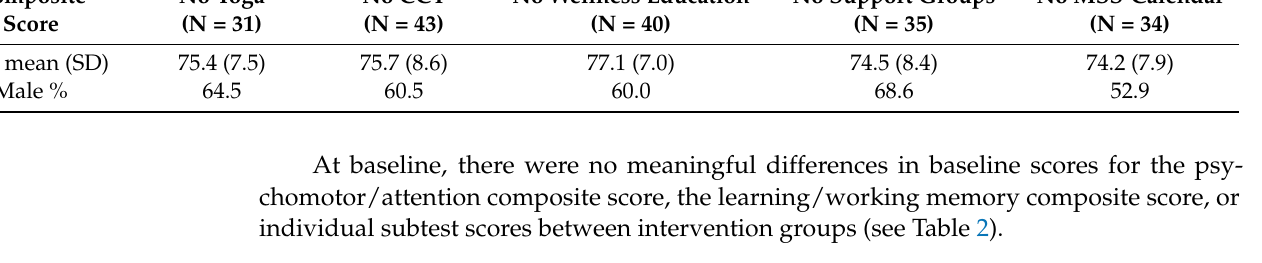
Table 1. Participant demographics at baseline by study arm.